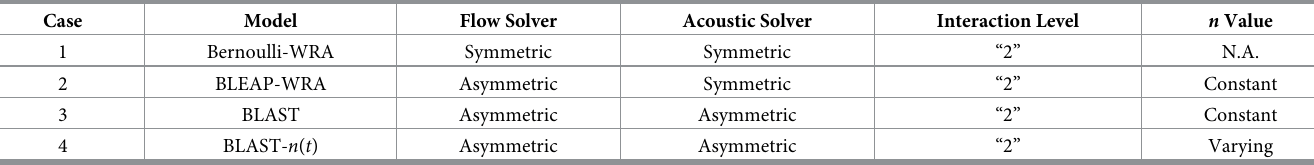
Table 1. Flow and acoustic solver reference table. Each of the fluid and acoustic solvers utilized for the investigations is listed, including whether they are based on a sym- metric or asymmetric flow formulation. For methods utilizing an acoustic solver, the level of interaction is listed, and for methods utilizing the BLEAP or BLAST solver the value for the flow exponent n (constant or varying) is